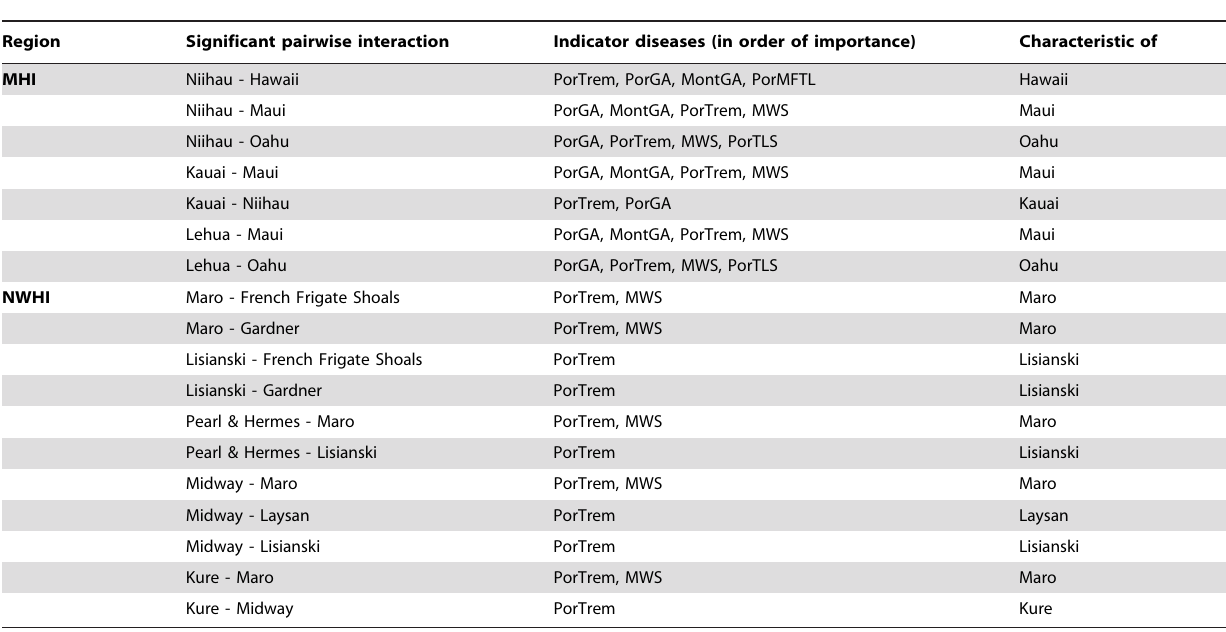
Table 6. Indicator diseases important in explaining differences in disease assemblages among islands within the main and northwestern Hawaiian Islands.